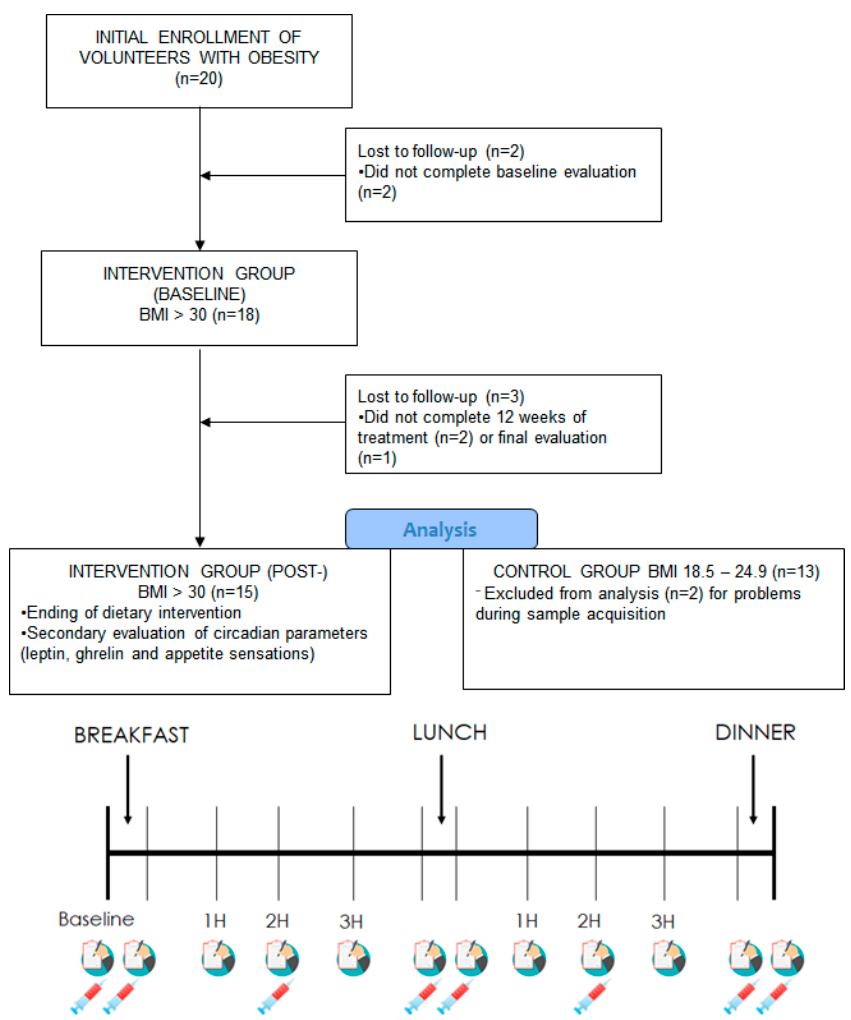
Figure 1. Flow diagram and study design. In the lower figure, the baseline indicates the first determination before having breakfast. 1H, 2H, and 3H indicate the time (in hours) after the end of the meal by part of the participants. BMI: body mass index.